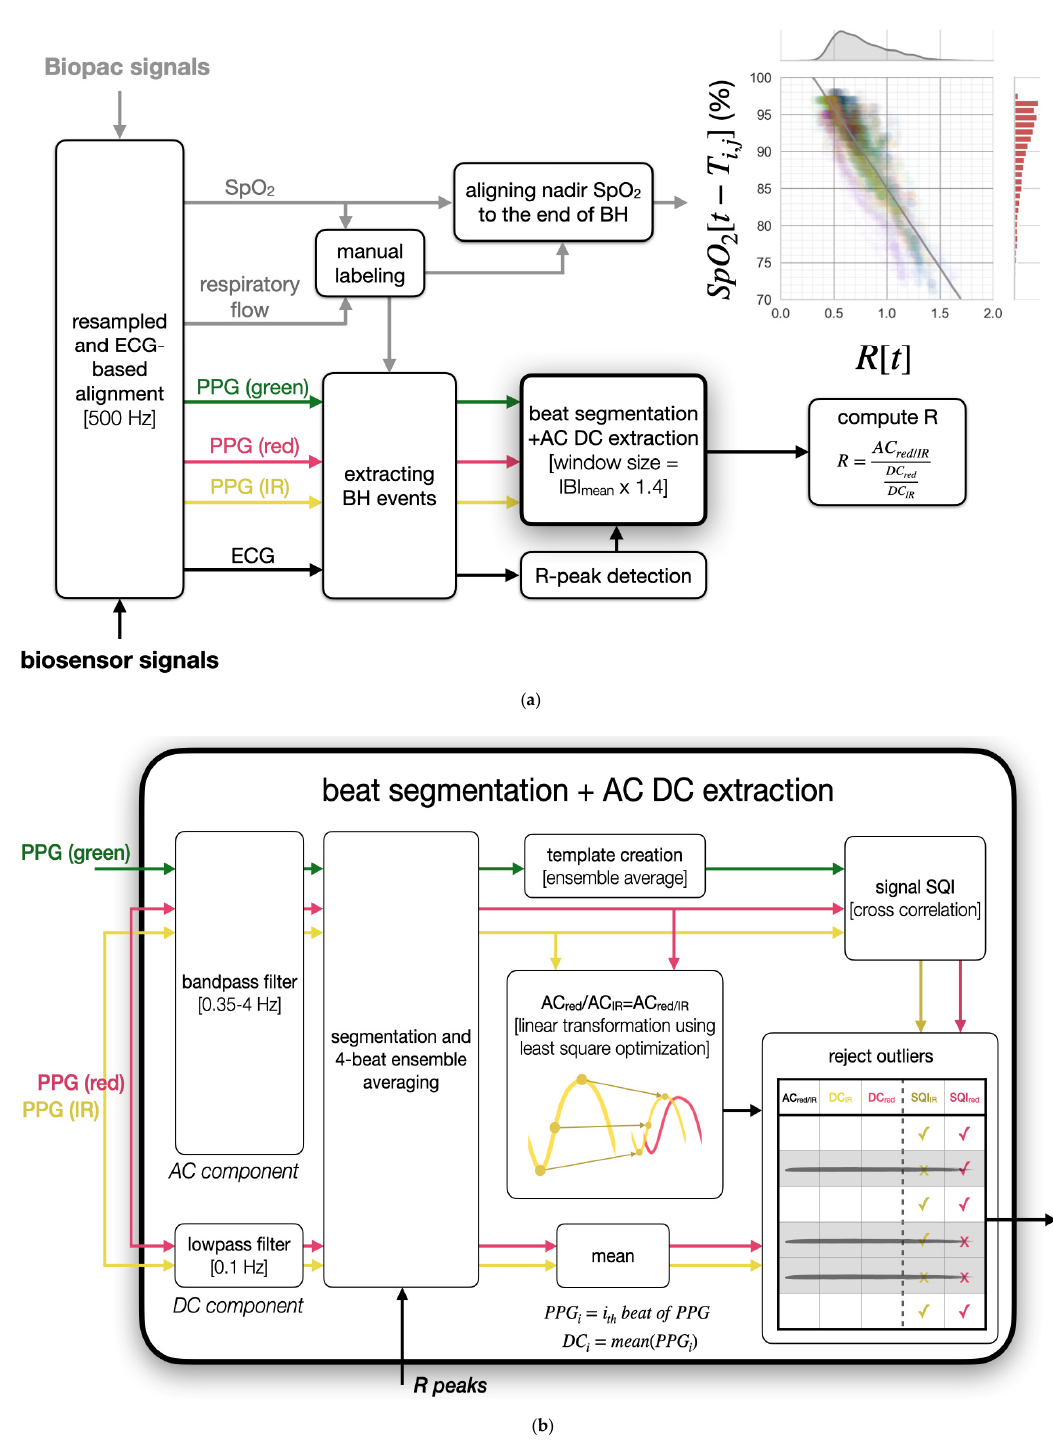
Figure 4. Feature extraction block diagrams. ( a ) Overview of the signal preprocessing and manual labeling pipeline. Extracted pairs of ratio of ratios (R) and SpO 2 were used for training and calibration of the model. T i,j denotes the delay found between R and SpO 2 for the j th breath-hold of subject i . The aligned data were displayed in the upper right scatter plot. The distribution of R and SpO 2 are also shown above and on the right of the scatter plot, respectively. IBI mean denotes the mean of the interbeat intervals (IBI) of a subject. ( b ) The block diagram for PPG beats segmentation, AC red/IR extraction, DC feature extraction, and PPG green -based outlier